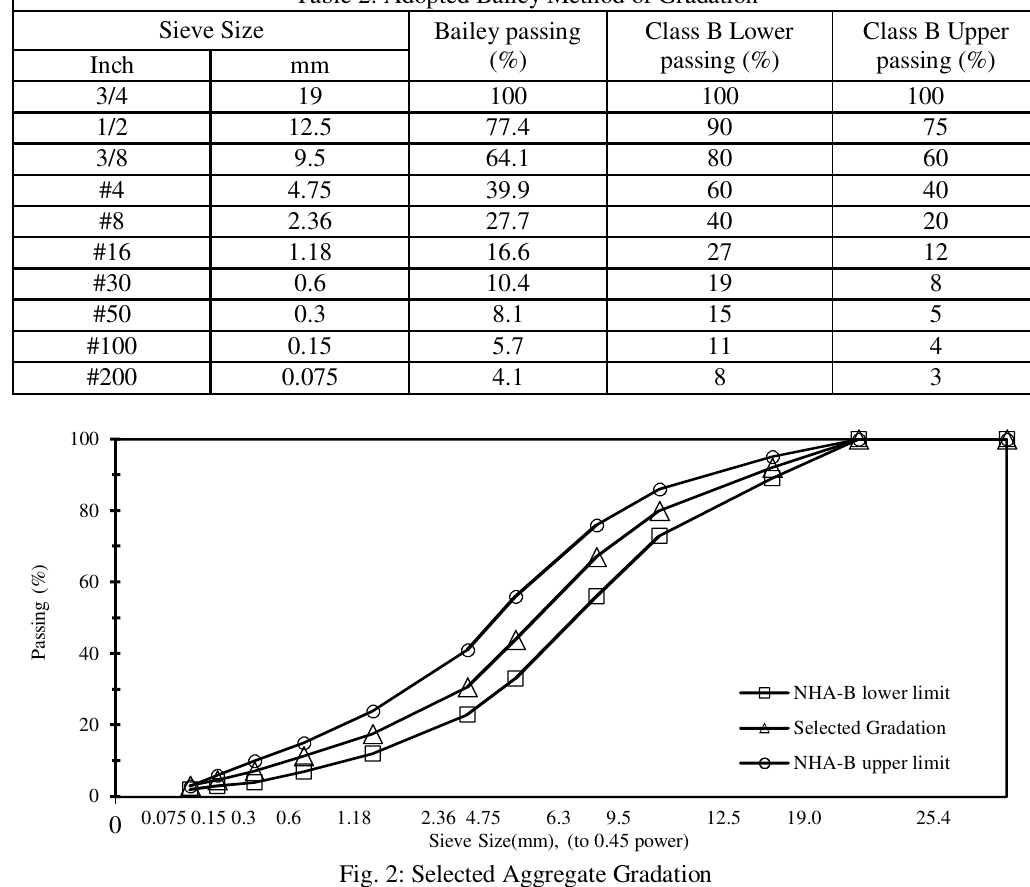
Fig. 2: Selected Aggregate